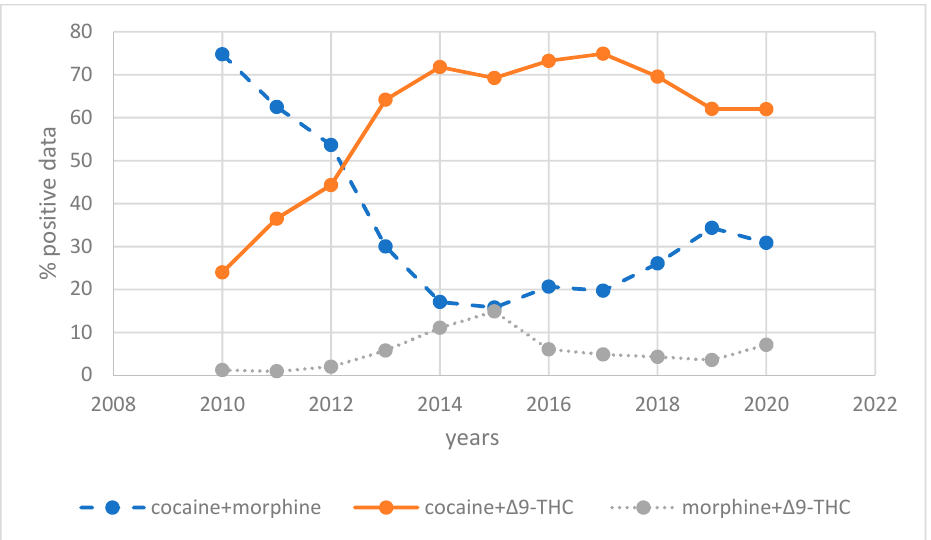
Figure 2. Drugs/year distribution of polydrug users’ group (PDU).